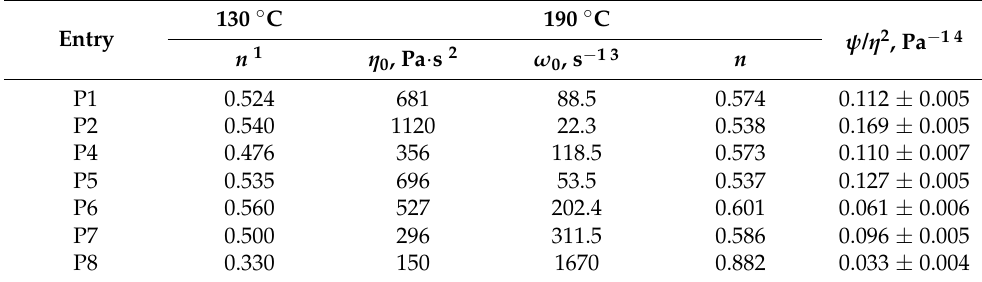
Table 2. Rheological characteristics of